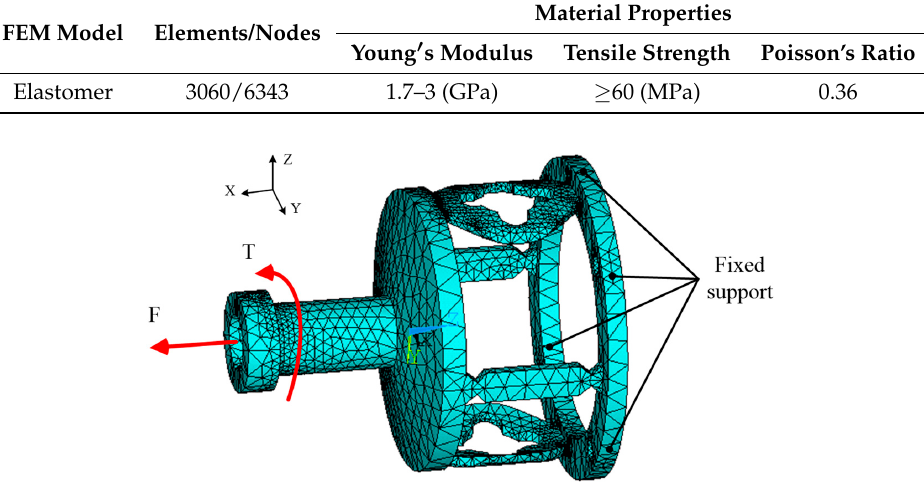
Table 2. Details of the finite element (FE) model and of the material properties used in the finite element method (FEM).